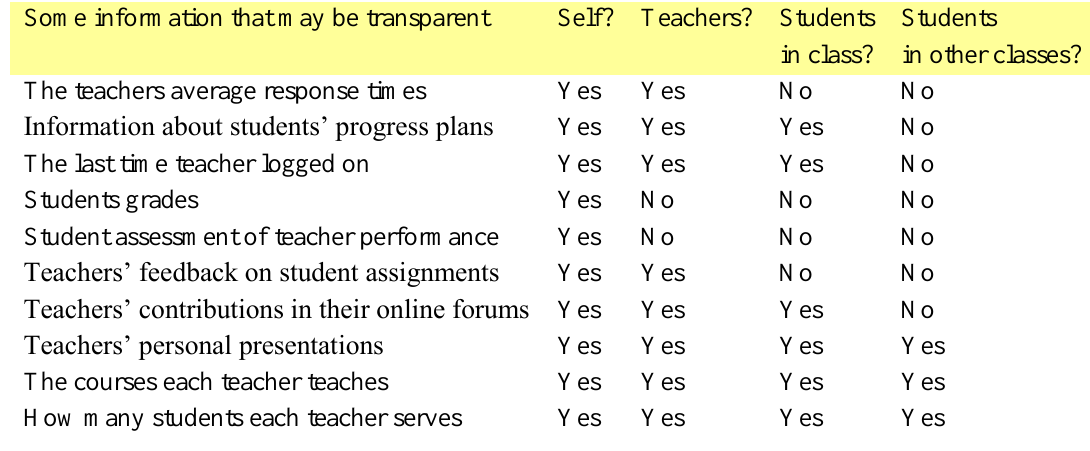
Transparency Matrix for Discussion of Transparency Levels in Virtual Learning Environments Some information that may be